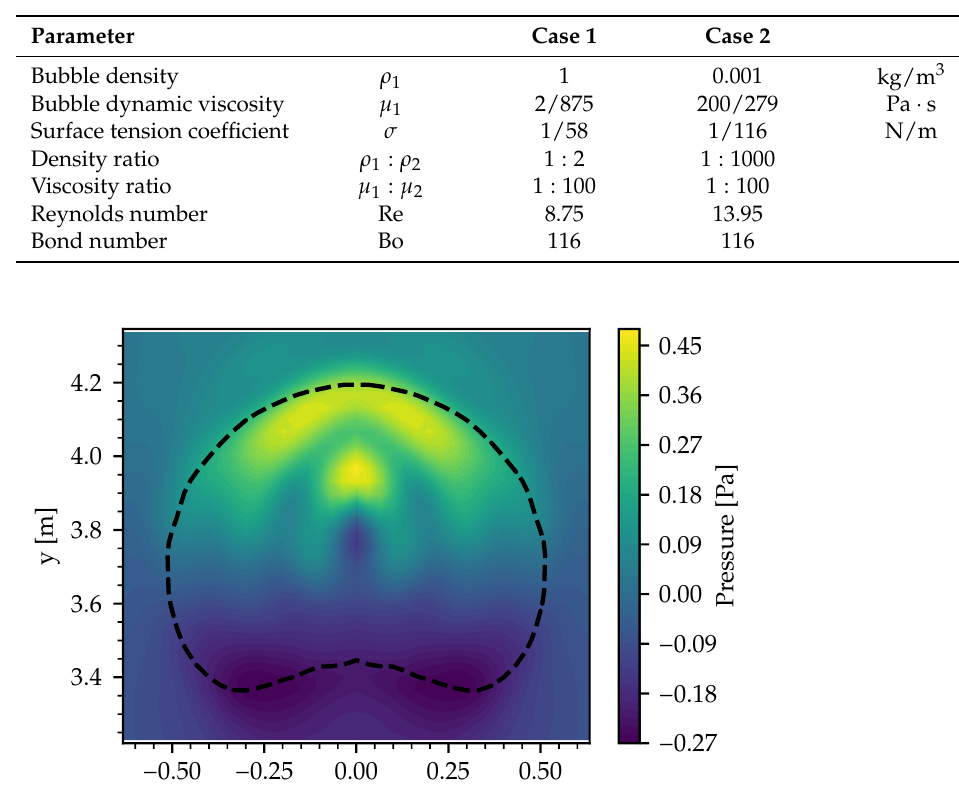
Table 3. Material and system properties for the rising bubble cases.